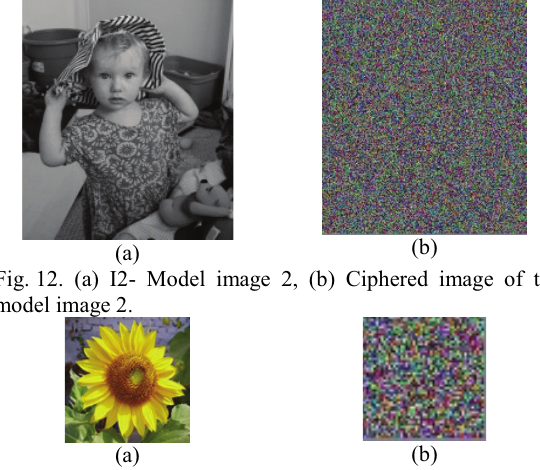
Fig. 11. (a) I1- Model image 1, (b) Ciphered image of the model image 1.